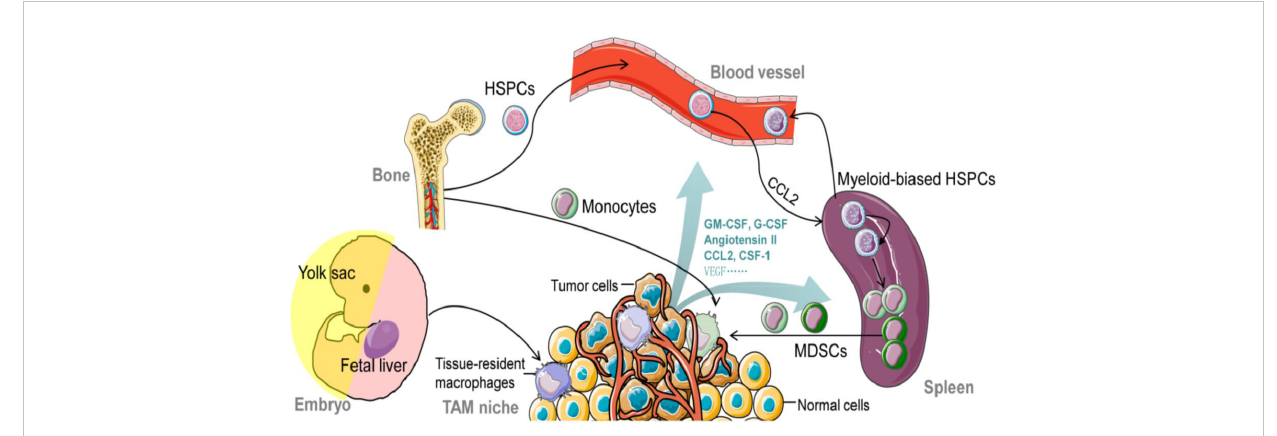
FIGURE 1 The origin of tumor-associated macrophages (TAMs). this fi gure was reproduced under common creative license